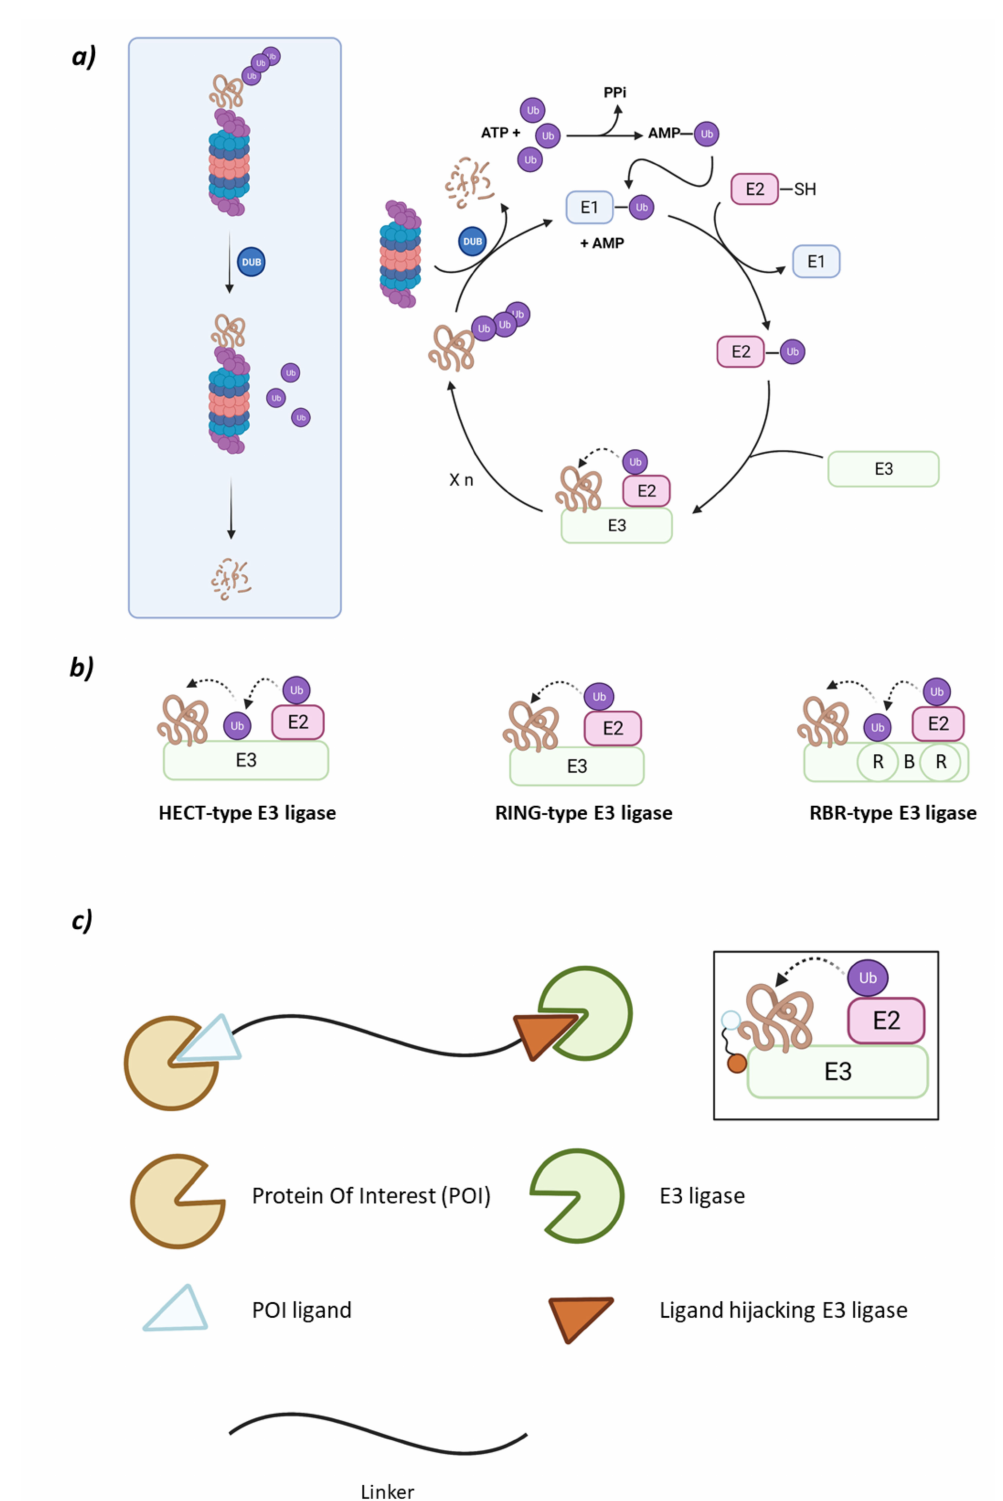
Figure 1. ( a ) Schematic representation of the Ubiquitin-Proteasome System (UPS) for substrate degradation. ( b ) Classification of the E3 ligase families according to their ubiquitination mechanism: HECT-type E3 ligase (indirect), RING-type E3 ligase (direct), and RBR-type E3 ligase (indirect). ( c ) Schematic representation of the overall structure and mechanism of action of